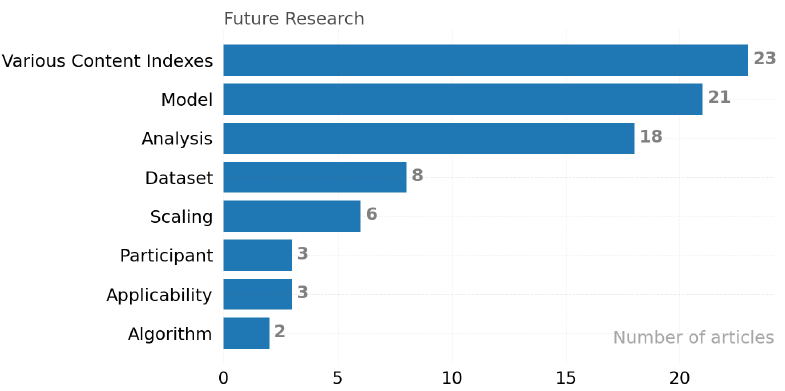
Figure 18. Future research